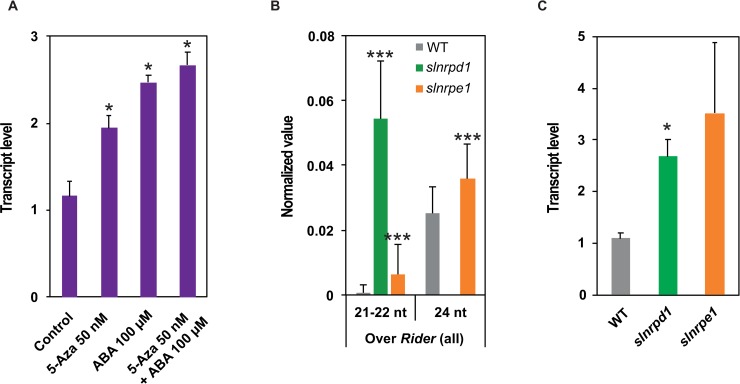
Accumulation of Rider transcripts in tomato plants deficient in epigenetic regulation.(A) Quantification of Rider RNA levels by RT-qPCR in tomato seedlings treated with 5-azacytidine and/or ABA. Bar charts show normalized expression relative to Control, +/- SEM from two to three biological replicates. *P<0.05, two-sided Student’s t-test. (B) Abundance of siRNAs at Rider elements in wild type, slnrpd1 and slnrpe1. Data are expressed as siRNA reads per kb per million mapped reads and represent average normalized siRNA counts on Rider elements +/- SD from 71 de novo annotated Rider copies. ***P<0.001, two-sided Student’s t-test. (C) Quantification of Rider RNA by RT-qPCR in slnrpd1 and slnrpe1. Bar charts show normalized expression relative to WT, +/- SEM from two to four biological replicates. *P<0.05, two-sided Student’s t-test.